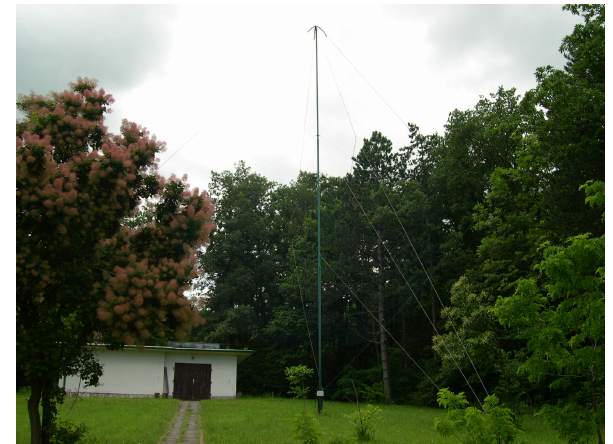
Figure 19. VLF antenna in front of the ionosonde station at the NCK observatory.